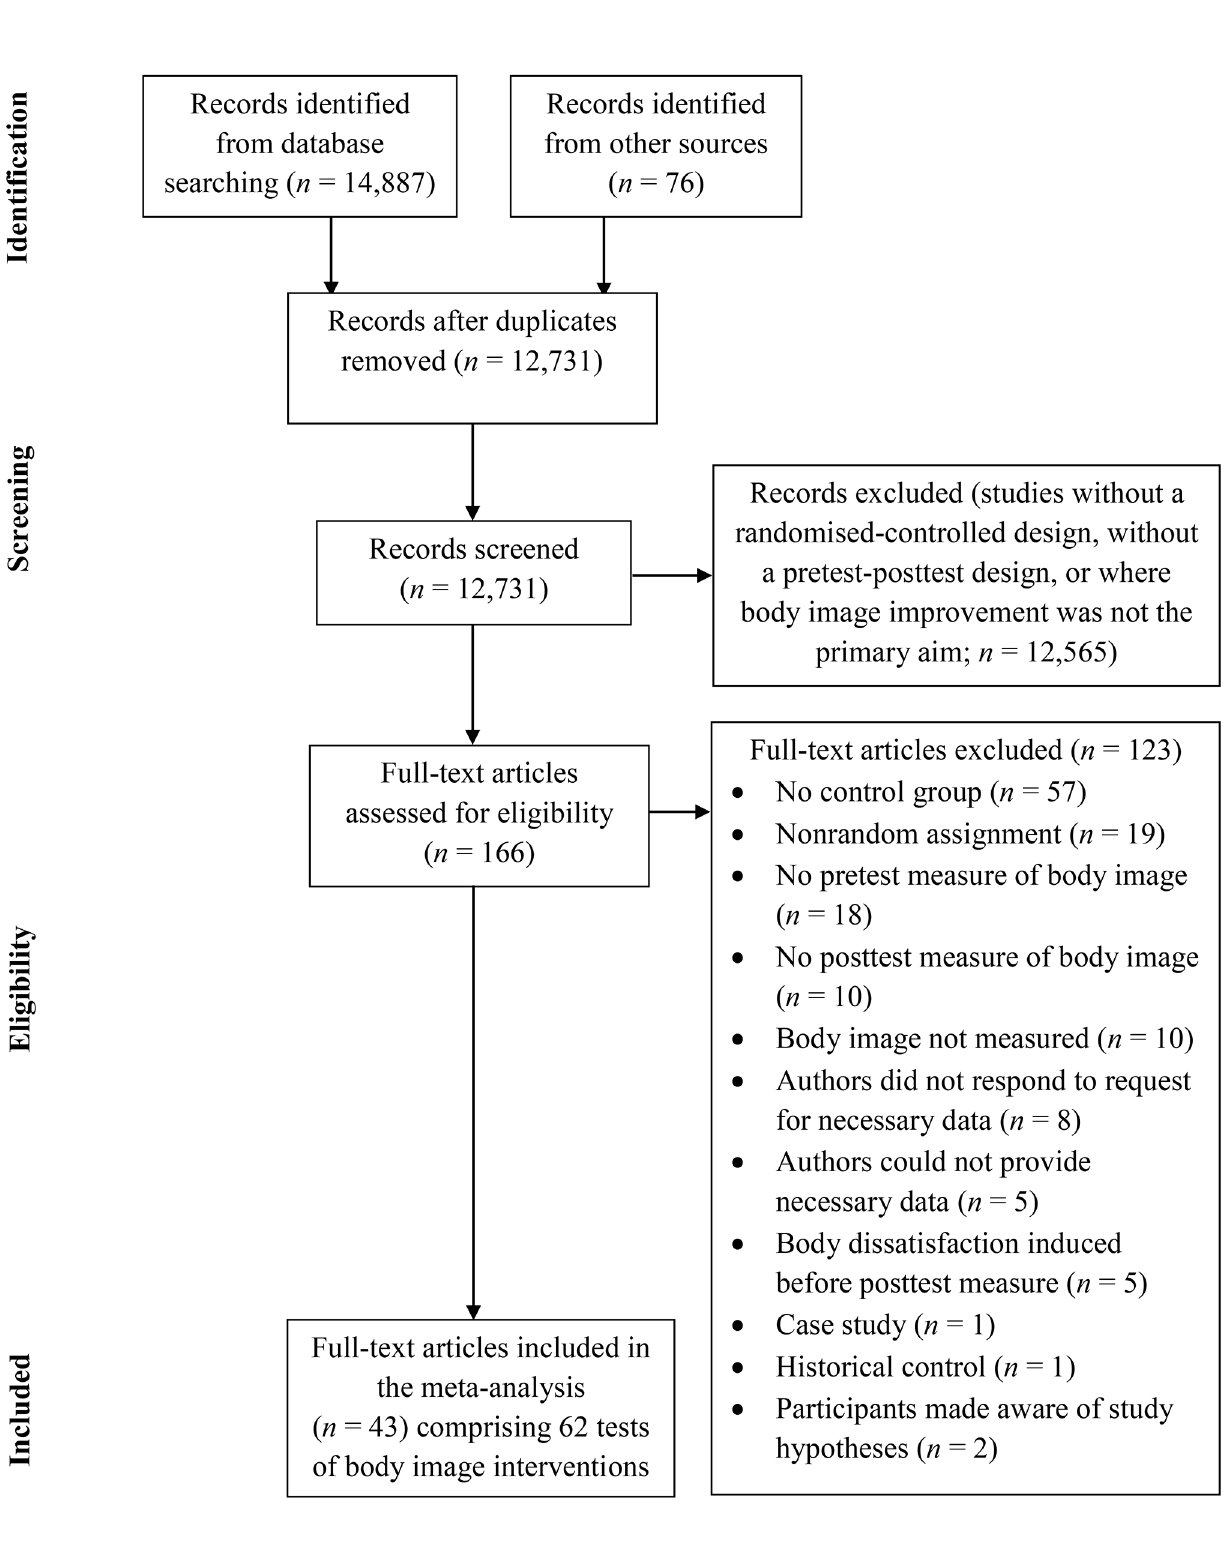
Fig 1. Flow of Studies through the Current